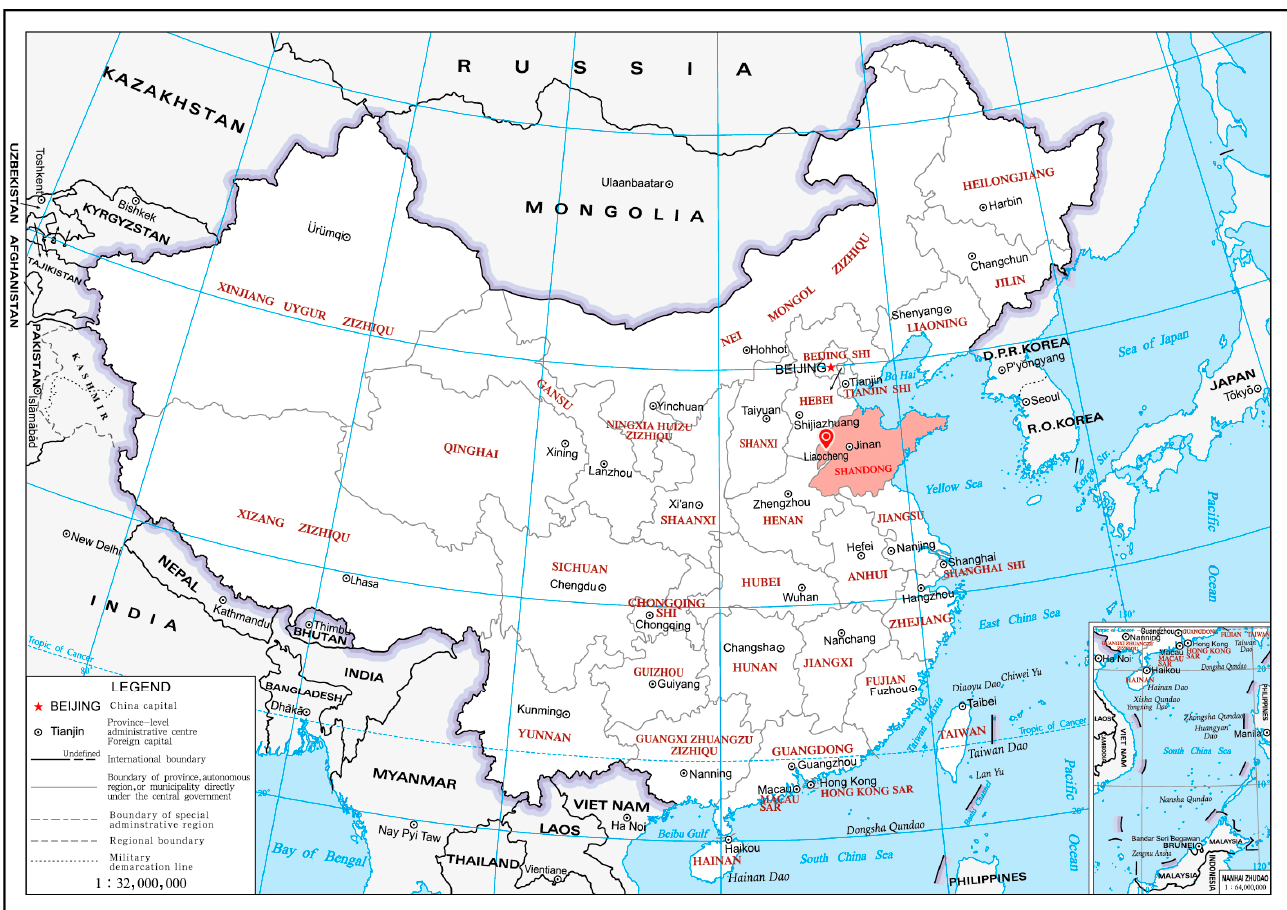
Figure 3. Location of Liaocheng City in Shandong Province, China (figure from the Standard Map of the People’s Republic of China; Approval Number: GS (2019) No. 1679).